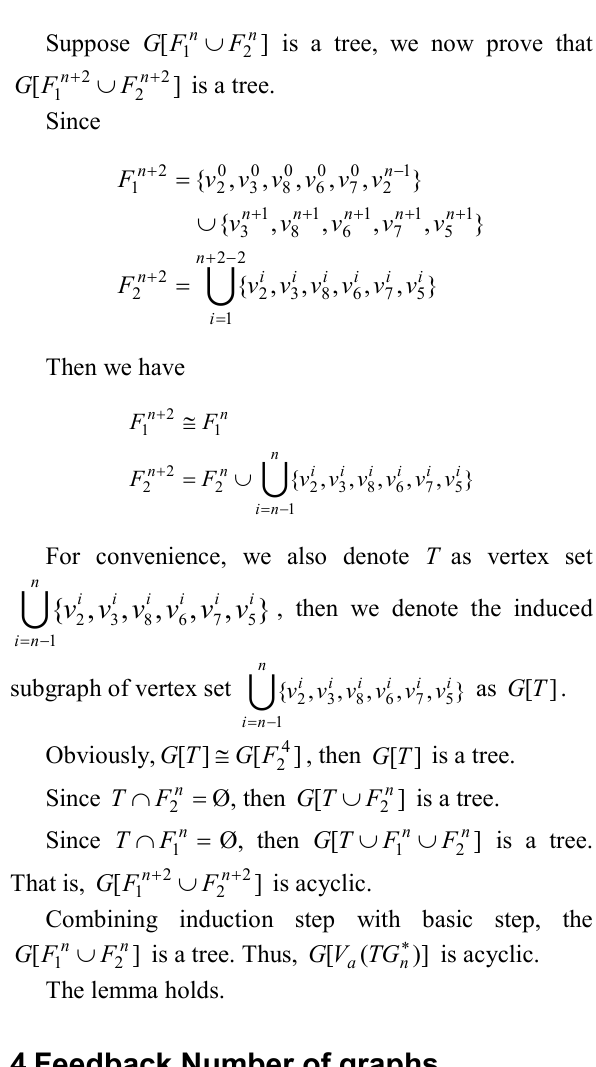
Figure 8. Subgraph of ][